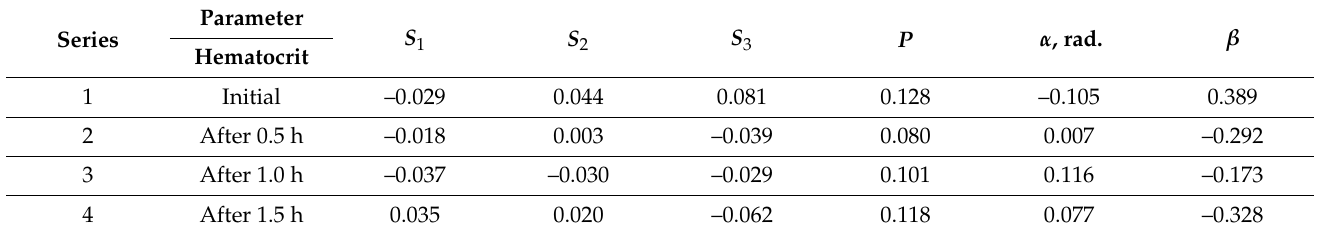
Table 1. Numerical values of the experimental